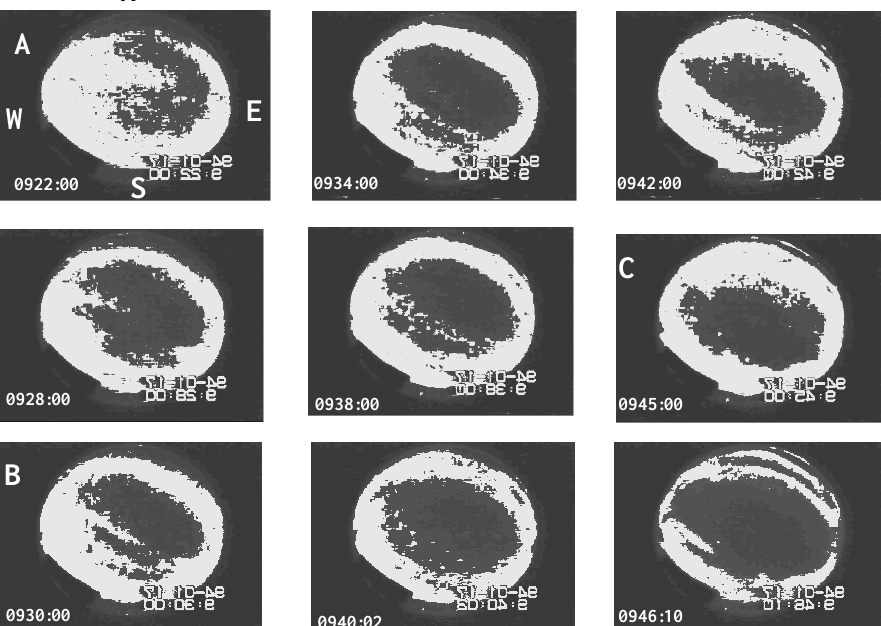
Figure 4. Nine all-sky images from 09:22:00 to 09:46:10UT for 17 January 1994. The auroras above 0.322–0.355 in the gray level were highlighted. The images labeled A, B, and C were taken at A, B, and C in Fig. 3. East is to the right, west is to the left, north is up, and south is down. The sequence sampled at ∼ 10s from 09:20:00 to 09:47:50UT is given in Animation_1 (see Supplement). Note that the gray level is reversed in the animation (darker colors for the brighter auroras) and were viewed from the ground, anti-parallel to the field lines. East is to the left and west to the right in the animation.